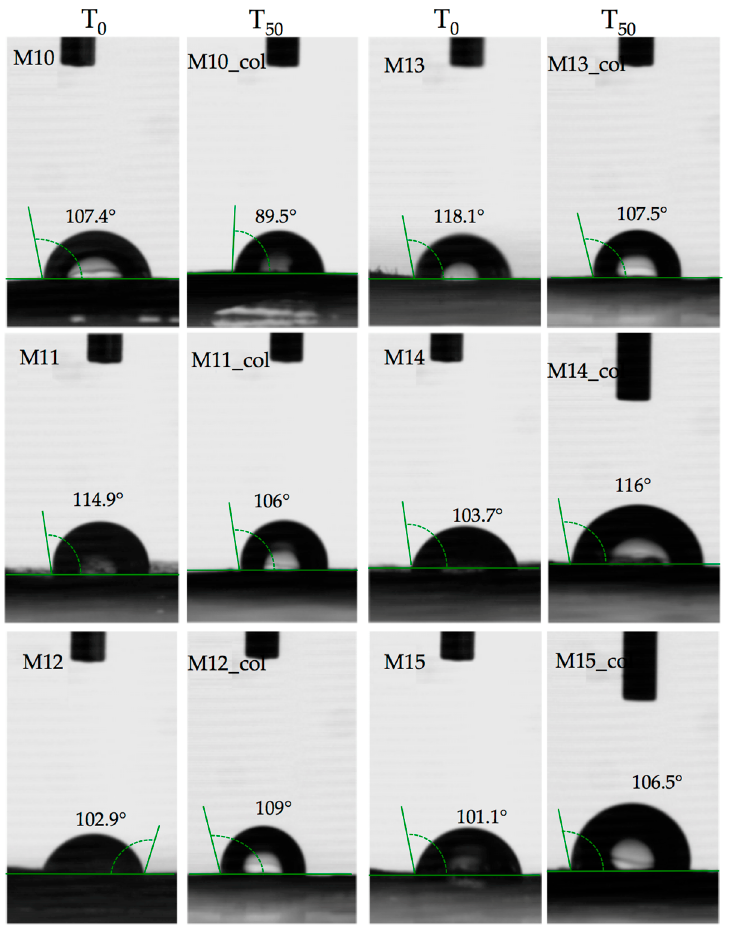
Figure 18. Contact angle of PET composites before and after collagen accumulation at 50 days (T 50 ).